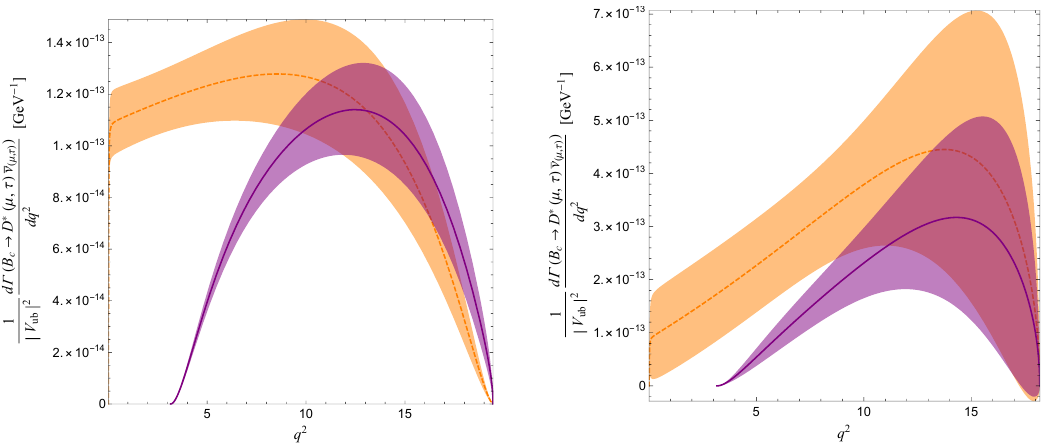
Figure 6 . Partial di(cid:11)erential decay rates with errors of B c semileptonic transitions to D (left), and to D (cid:3) (right), where the orange solid-line/area corresponds to (cid:22) in the (cid:12)nal state, and the purple dashed-line/area to the case with (cid:28) (cid:12)nal